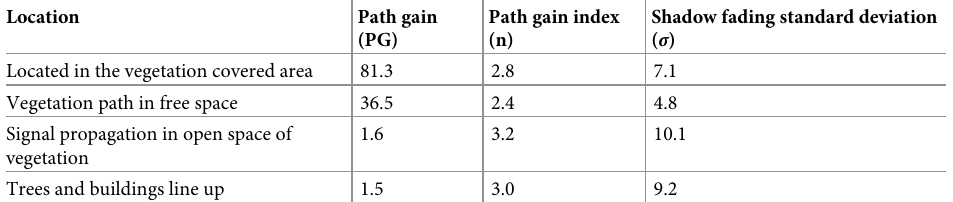
Table 2. Channel large-scale fading measurement statistics (points in Beijing University of science and